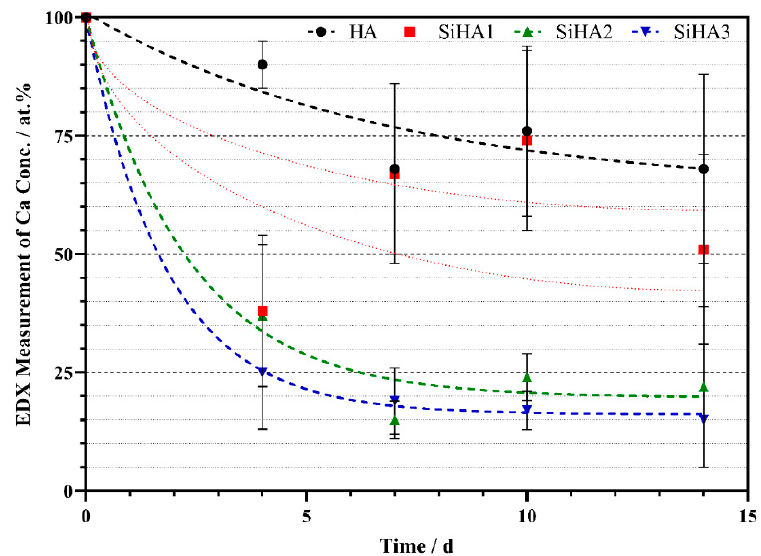
Figure A1. Percentage of HA and SiHA thin films annealed at 600 ◦ C remaining as a percentage of original coating Ca content. Data plotted is mean ± standard error of the mean; n = 4. Non-linear one-phase decay regression plots were calculated using GraphPad Prism software based on the data shown. Due to the high variance of the SiHA1 sample, a suitable regression line was unable to be plotted, hence a probable area has manually been fitted for visual enhancement.